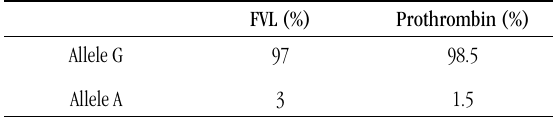
tABLE 2 – Allelic frequency of FVL and prothrombin alleles in the studied